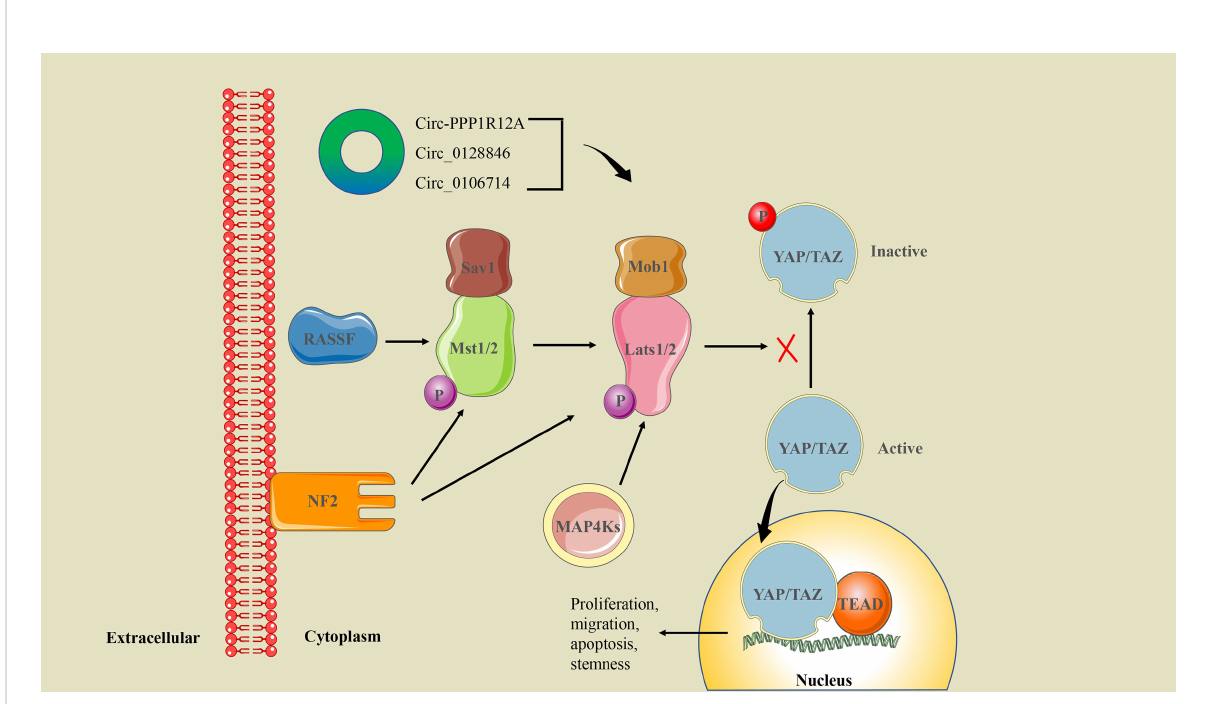
FIGURE 7 The circRNA/Hippo/YAP signaling axis in CRC. Mst1/2 is activated by upstream NF2 and RASSF family proteins. Phosphorylated Mst1/2 and MAP4Ks transmit multiple signals to activate Lats1/2, which inhibit YAP/TAZ phosphorylation. The activated YAP/TAZ enters the nucleus and binds with the transcription factor TEADs to induce gene expression. Ultimately, it regulates cell proliferation, migration, apoptosis, and the stemness properties of